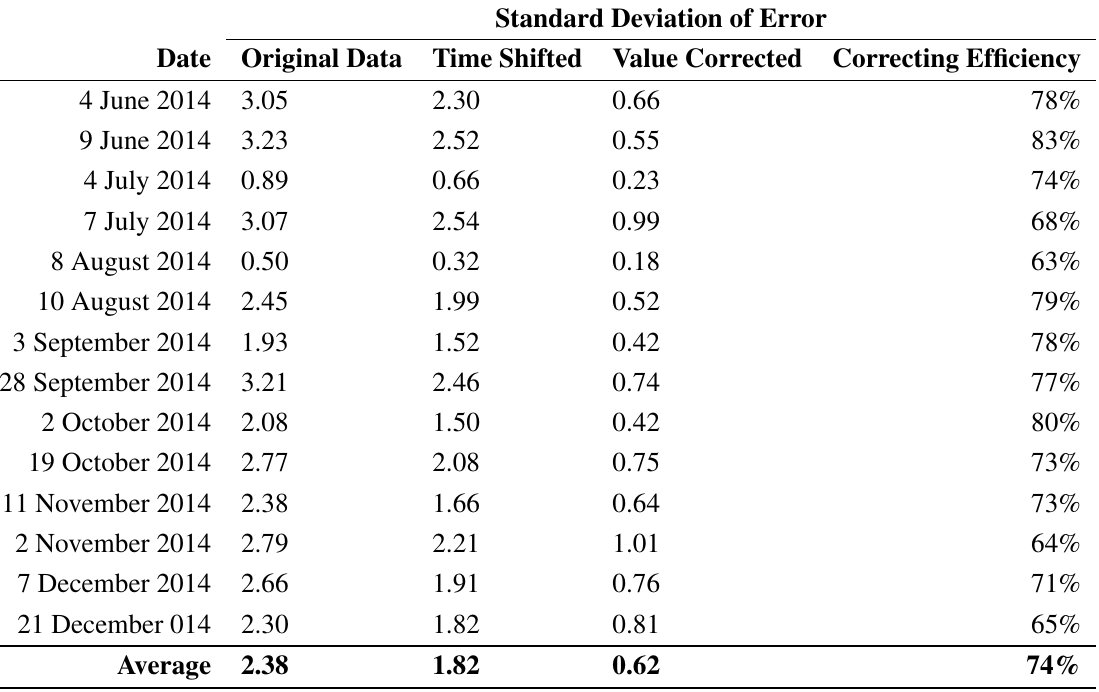
Table 5. Standard deviation of the error in different correcting